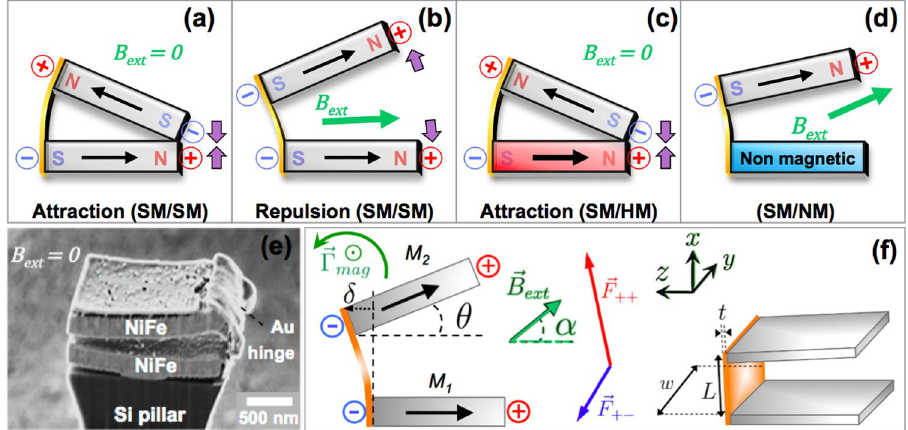
Figure 1. ( a , b ) The jaws in SM/SM tweezers attract and repulse each other in the absence and presence of an external field, respectively. ( c ) The hard magnetic jaw in the SM/HM tweezers have a stronger magnetostatic influence on the soft magnetic jaw. ( d ) The nonmagnetic jaw exerts no magnetostatic force on soft magnetic jaw. ( e ) SEM image of a SM/SM tweezer. ( f ) Coordinate system and definition of the variables that are used for the